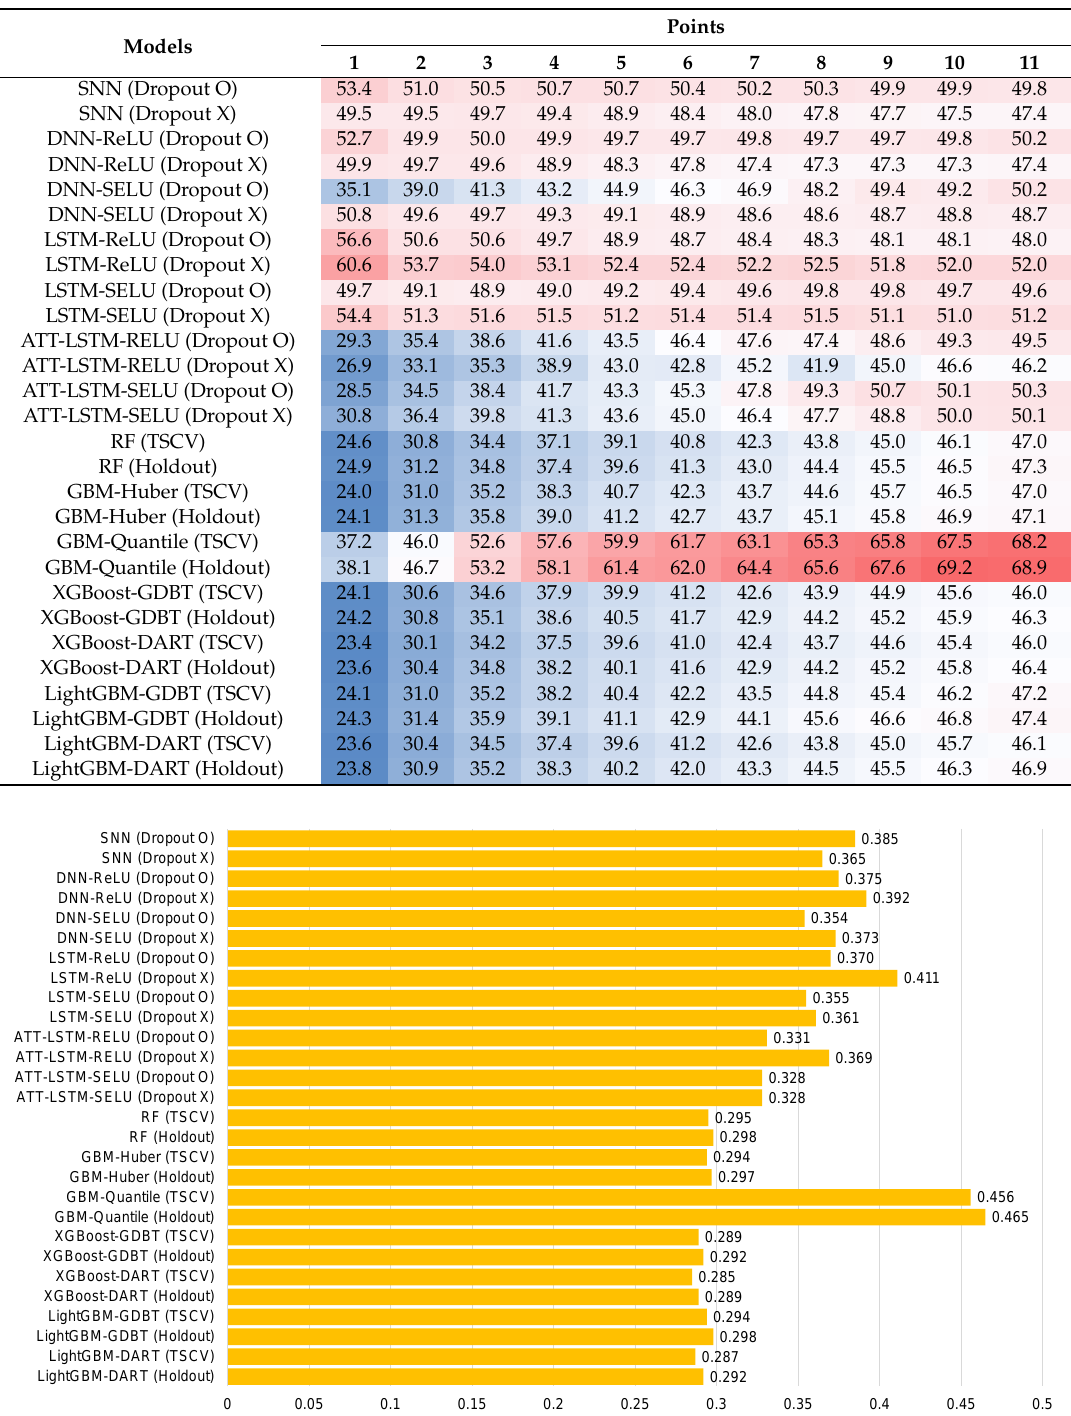
Table 12. Normalized root mean square error (NRMSE) distribution for each model for Gosan-ri. A cooler color indicates a lower NRMSE value, whereas a warmer color indicates a higher NRMSE value (%).